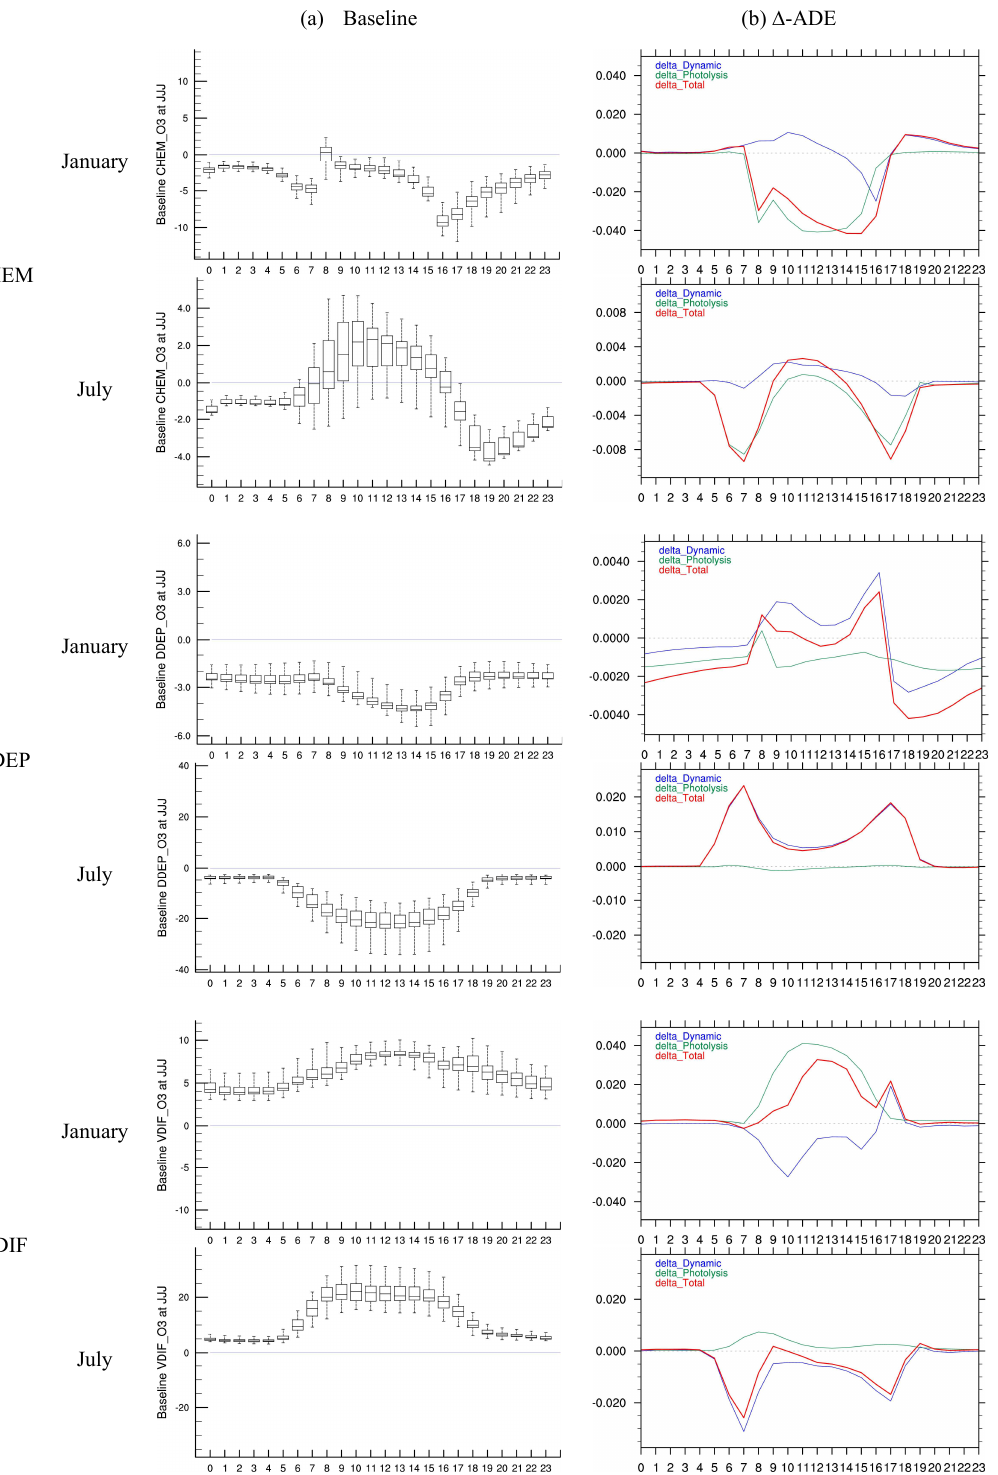
Figure 4. Diurnal variation in selected integrated process contributions to surface O 3 concentration in JJJ. The calculation is based on the average of grid cells in JJJ; (a) baseline is the simulated O 3 in SimBL (unit: ppbh − 1 ); (b) (cid:49) -ADE is the difference in normalized IPRs between simulations (unit: h − 1 ). Delta_Dynamic is the difference between SimSF and SimNF; delta_Photolysis is the difference between SimNF and SimBL; delta_Total is the difference between SimSF and